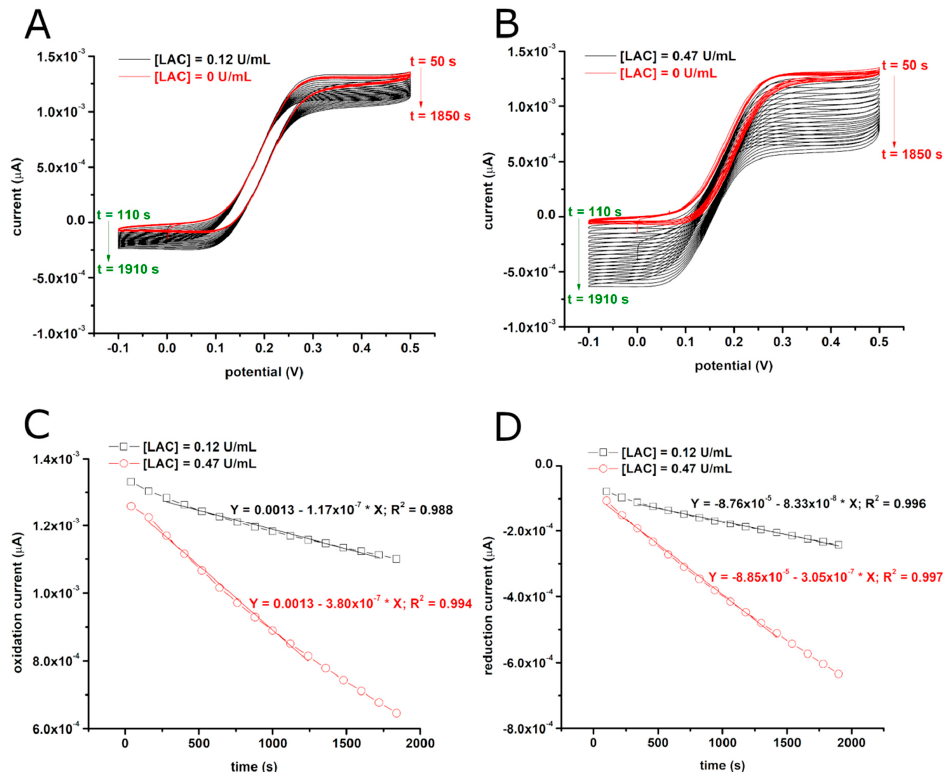
Figure 1. Cyclic voltammograms recorded at a potential scan rate of 10 mV/s in solutions with 0.5 mM 2,2 ′ -azino-bis(3-ethylbenzothiazoline-6-sulfonic acid) (ABTS) and with two different concentrations of laccase ([LAC]) ( A , B ), and the time evolution of the current in these voltammograms at +0.4 V (where the current is proportional with the concentration of reduced ABTS) and at 0 V (where the current is proportional with the concentration of oxidized ABTS) ( C , D ). It is important to note that a negative slope corresponds to current decreases in C and D (as reduction currents are considered negative).